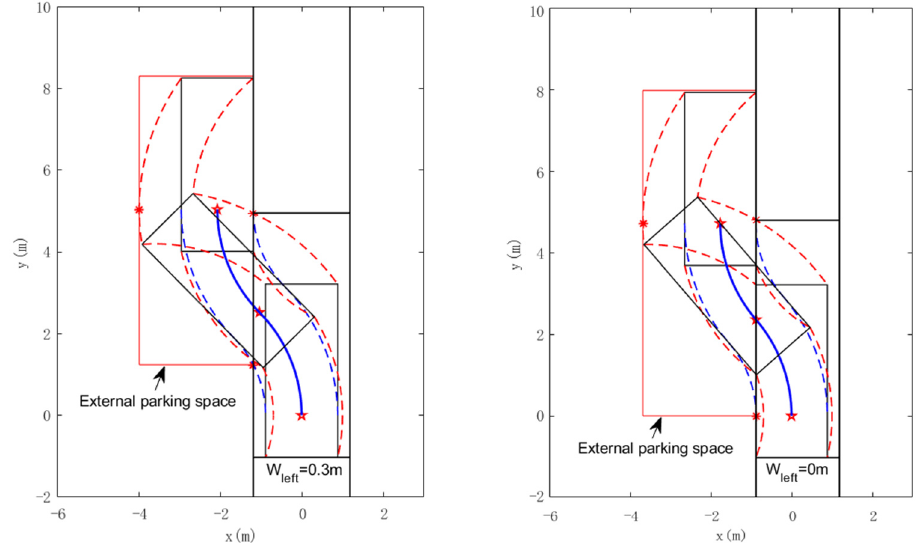
Figure 10. Simulation of the parking for two different W left